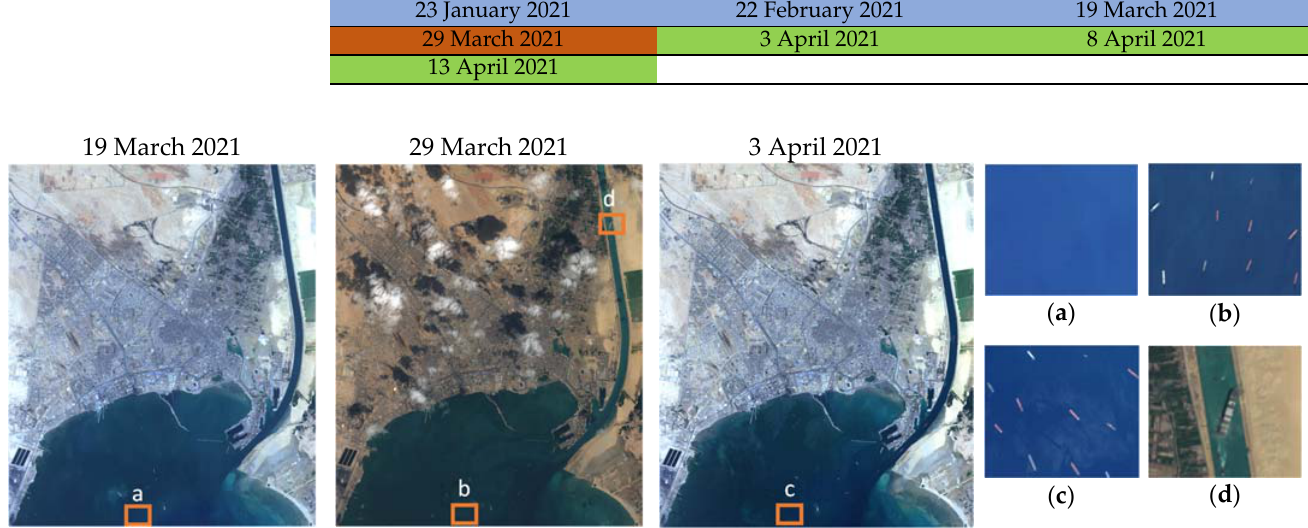
Figure 1. Multitemporal Sentinel-2 imagery of the southern part of the Suez Canal before, during, and after the ship blockage. Image subsets ( a – d ) show the location of the stuck ship and also the traffic jam.